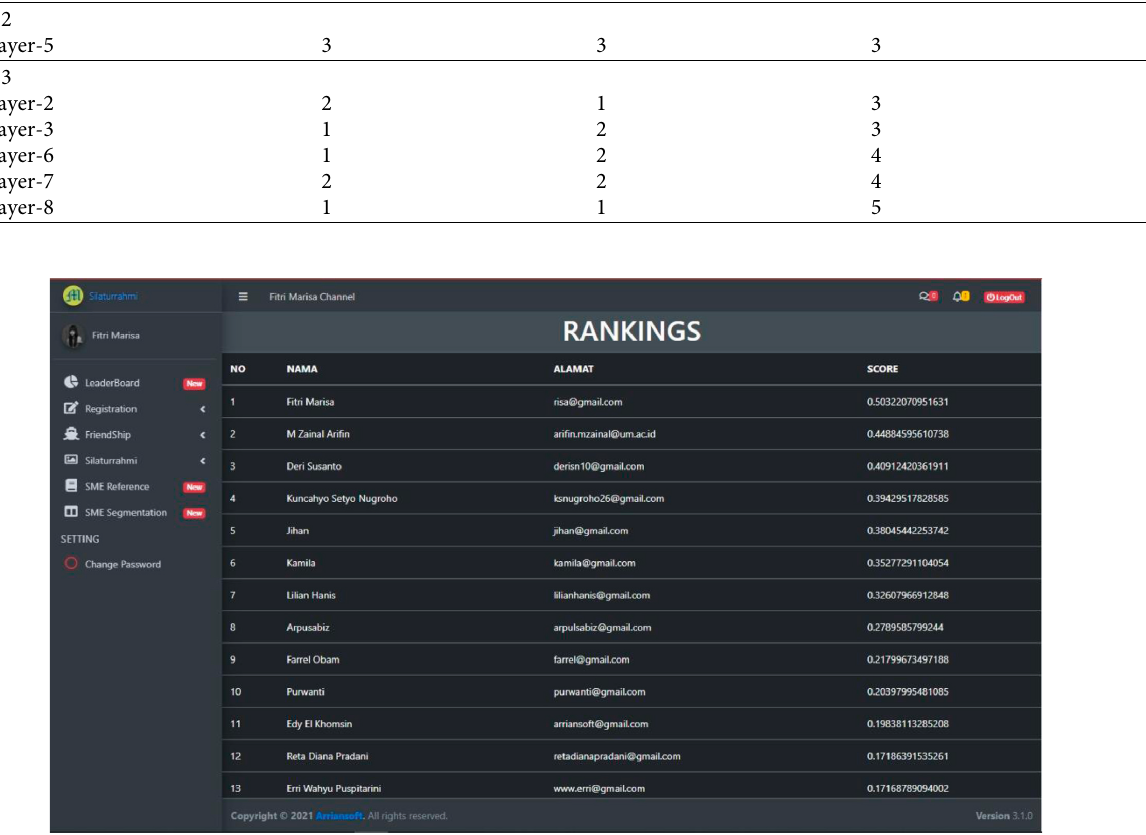
Figure 3: SME ranking using fuzzy-AHP.